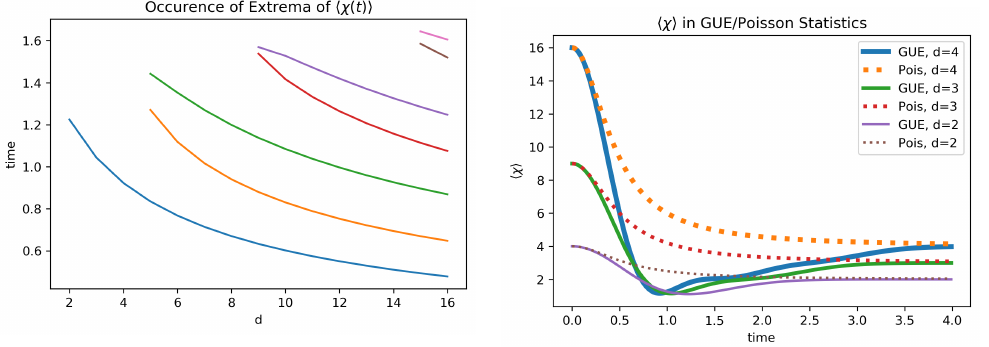
Figure 13: Plot of extremum positions of 〈 χ ( t ) 〉 against d . until d = 5, there is just one minimum, in steps new ’folds’ with a max and min appear.